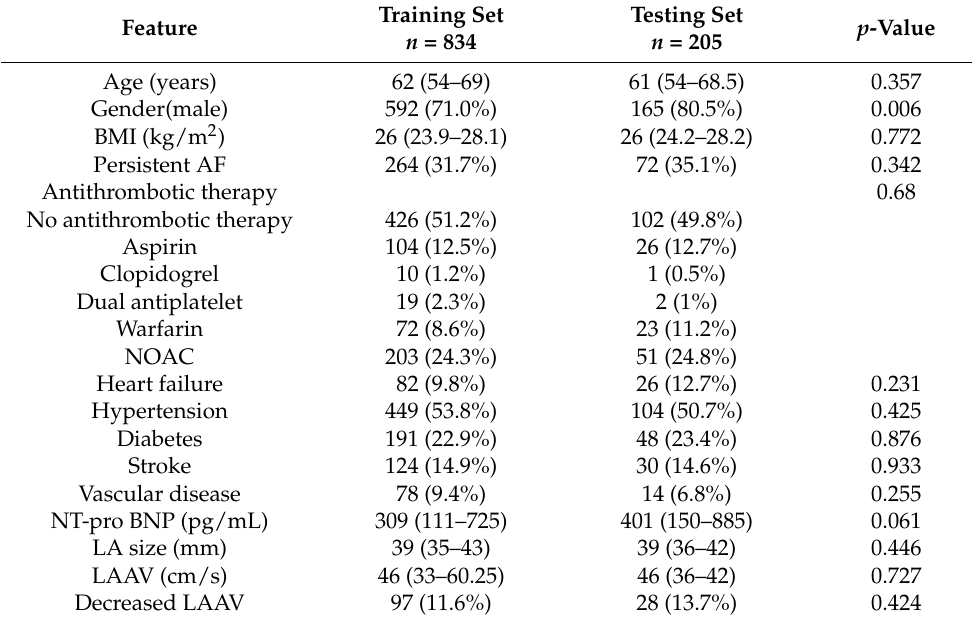
Table 2. The characteristics of training set and testing set.